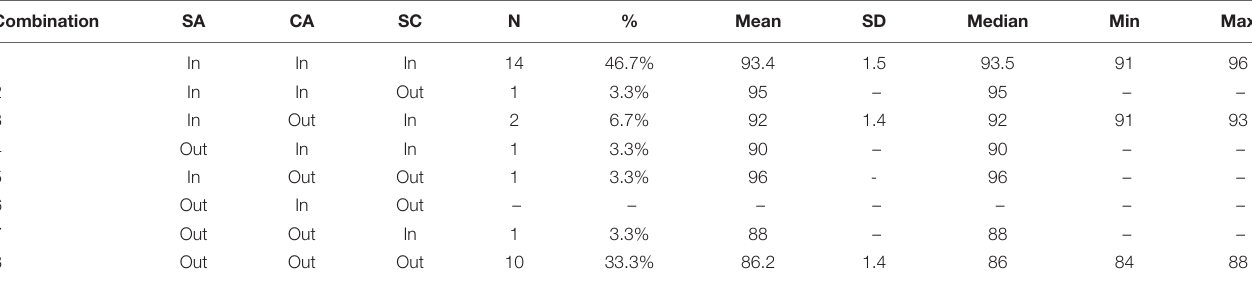
FIGURE 3 | The best performance scores and CSAI-2 subscales inside or outside the IZOF for participant #29. The green band represents the IZOF of participant #29. The red and blue horizontal lines represent the lowest and highest scores of the best performance scores. The blue spots indicate the performance scores. TABLE 3 | Predictive in-zone performances and the statistic description of actual performance